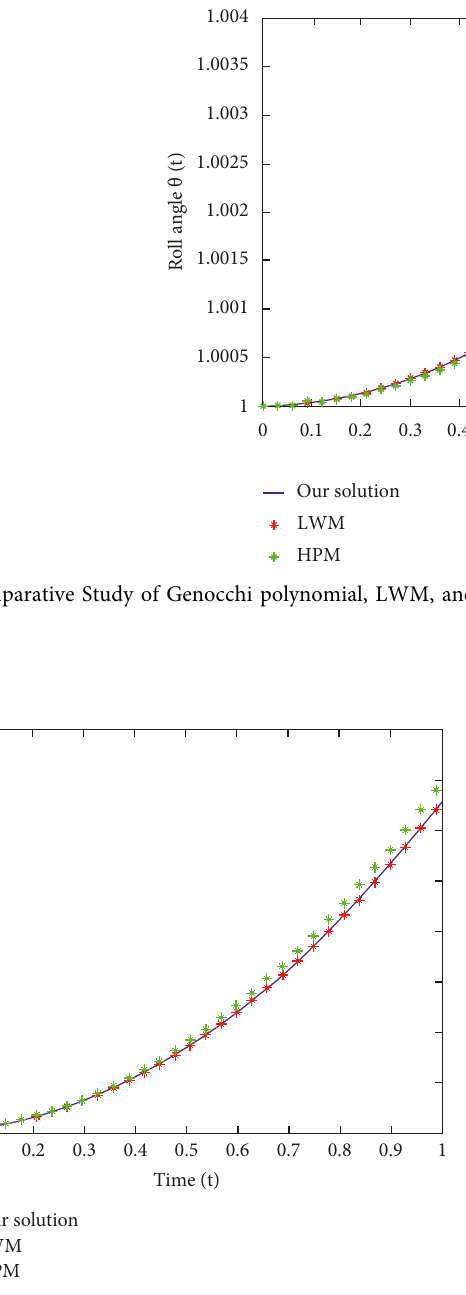
Figure 7: Comparative Study of Genocchi polynomial, LWM, and HPM for roll angle with respect to the time t (in sec) for